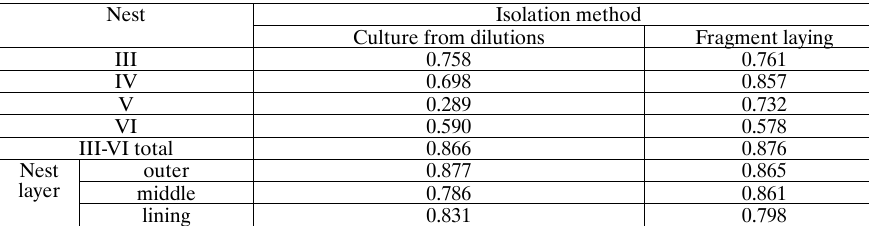
simpson’s indices (D) for cellulolytic fungi in entire nests and individual layers of the nests of Montagu’s Harrier ( Circus pygargus